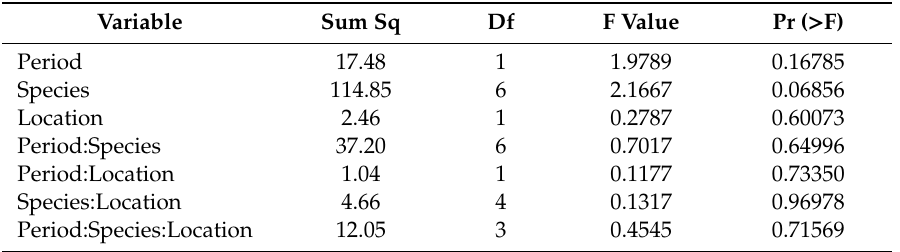
Figure 8. Effect plot showing the estimated mean IRs in Olama and Nyabessan before and after dam construction. IR: infection rate; A. gb : Anopheles gambiae s.l. ; A. ms : Anopheles marshallii ; A. mc : Anopheles moucheti ; A. ov / ni : Anopheles ovengensis or A. nili ; A. pl : Anopheles paludis ; A. zi : Anopheles ziemanni . Table 4. ANOVA table for model of infection rates (IR) as a function of periods before and during dam construction, location, and